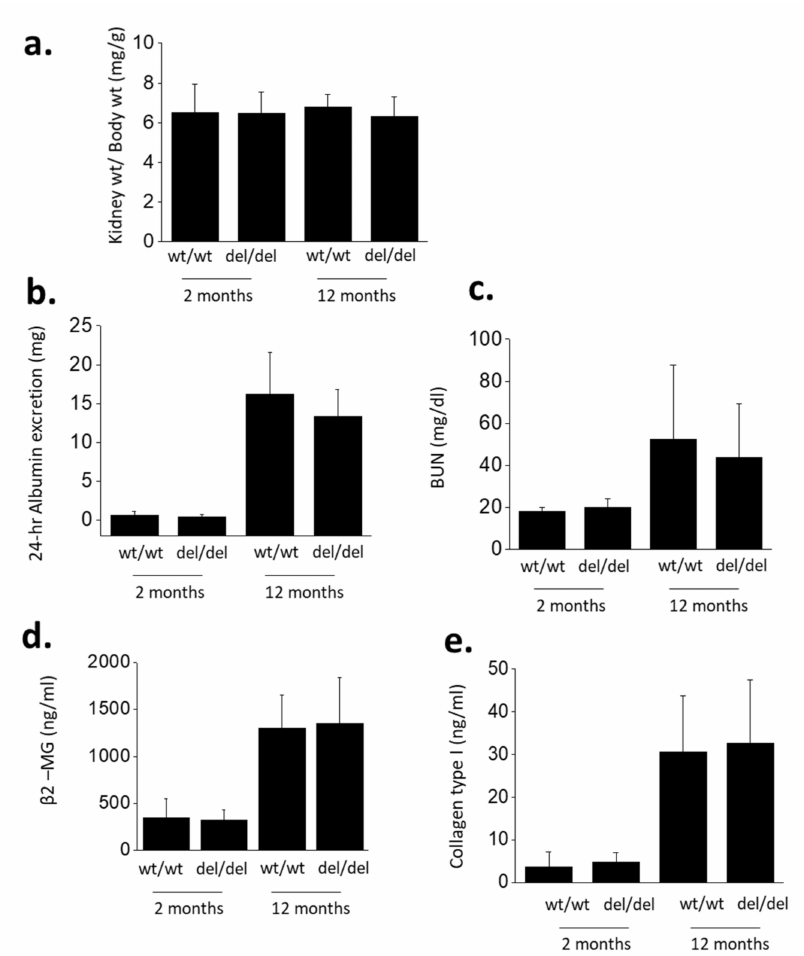
Figure 2. Markers of renal function in Trpc6 wt/wt and Trpc6 del/del rats at 2 and 12 months of age as indicated. Mean ± SD are shown for kidney weight/body weight ( a ), 24-h urine albumin excretion ( b ), blood urea nitrogen (BUN) ( c ), urine β 2-microglobulin ( d ) and serum procollagen type 1 peptide ( e ). Two-way ANOVA of these data indicates that absence of functional TRPC6 channels had no effect on declines in these renal function parameters during